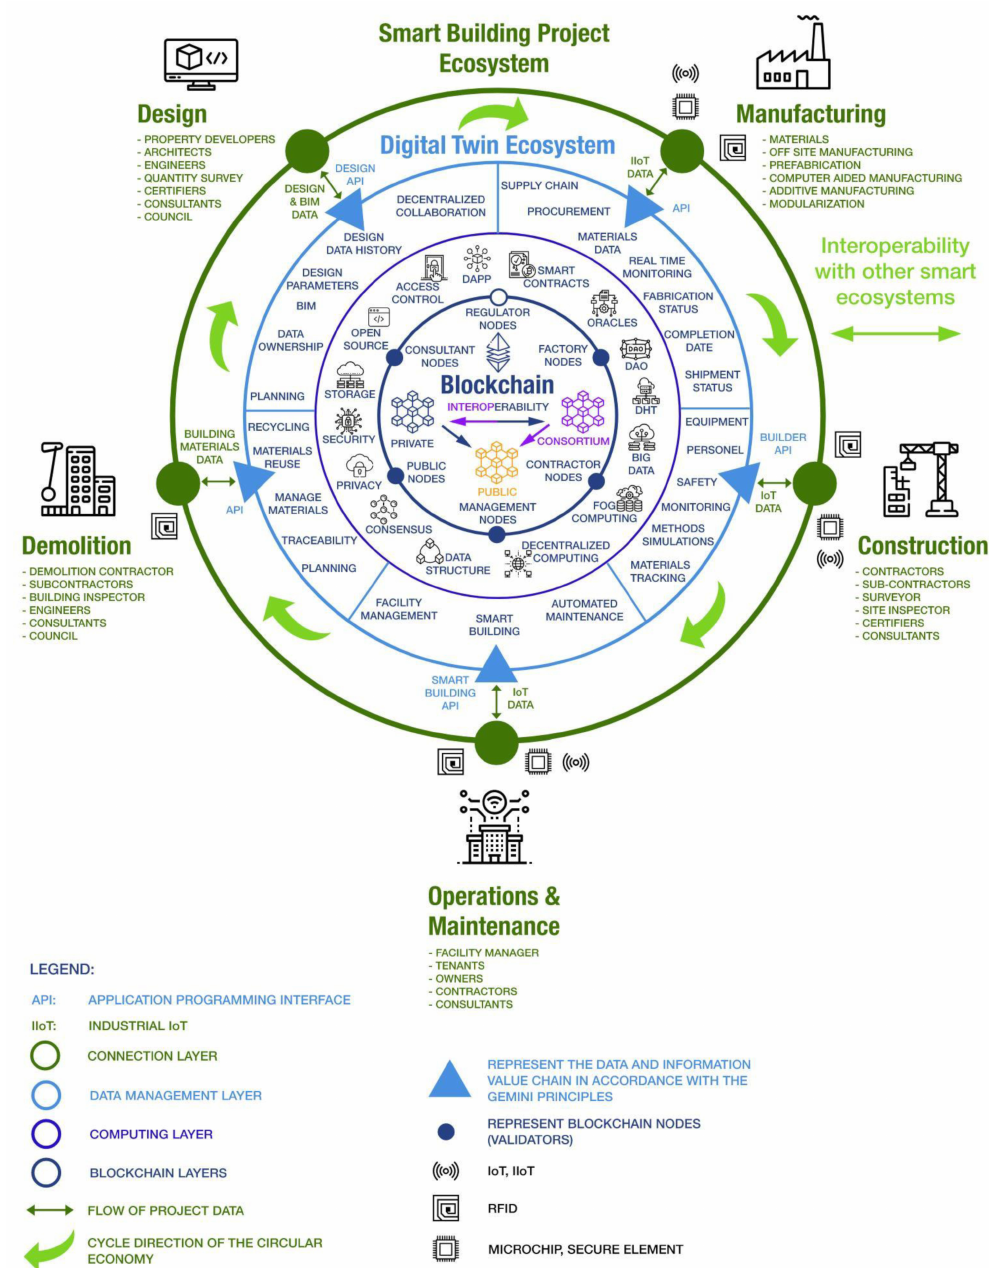
Figure 2. The decentralized digital twin